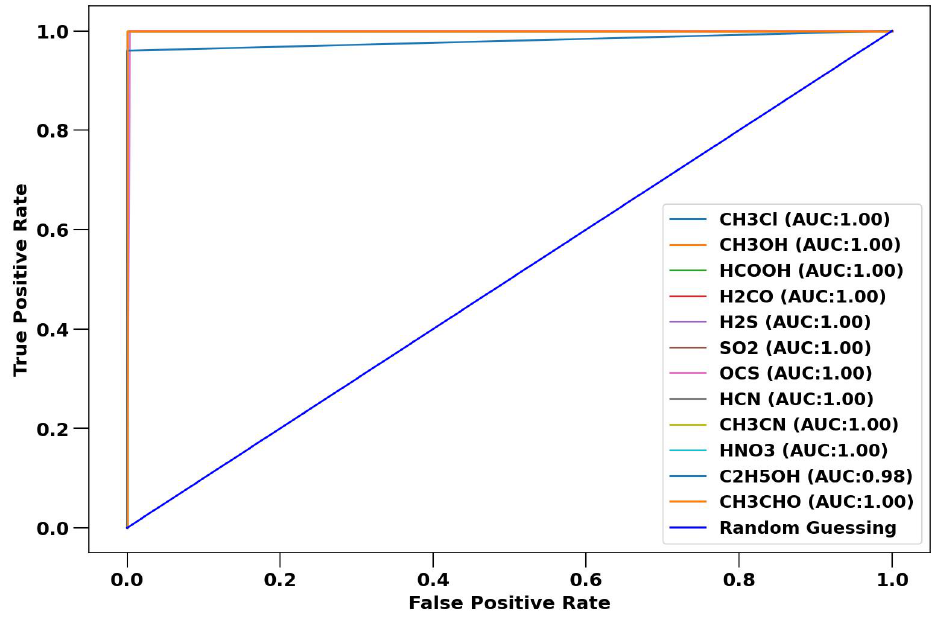
Figure 10. ROC curve for the classification of 591 simulated validation